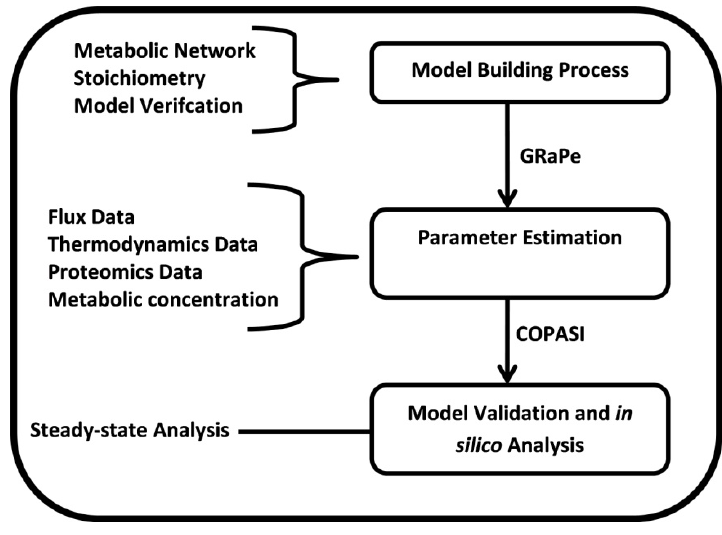
Figure 1. Schematic overview of the model development